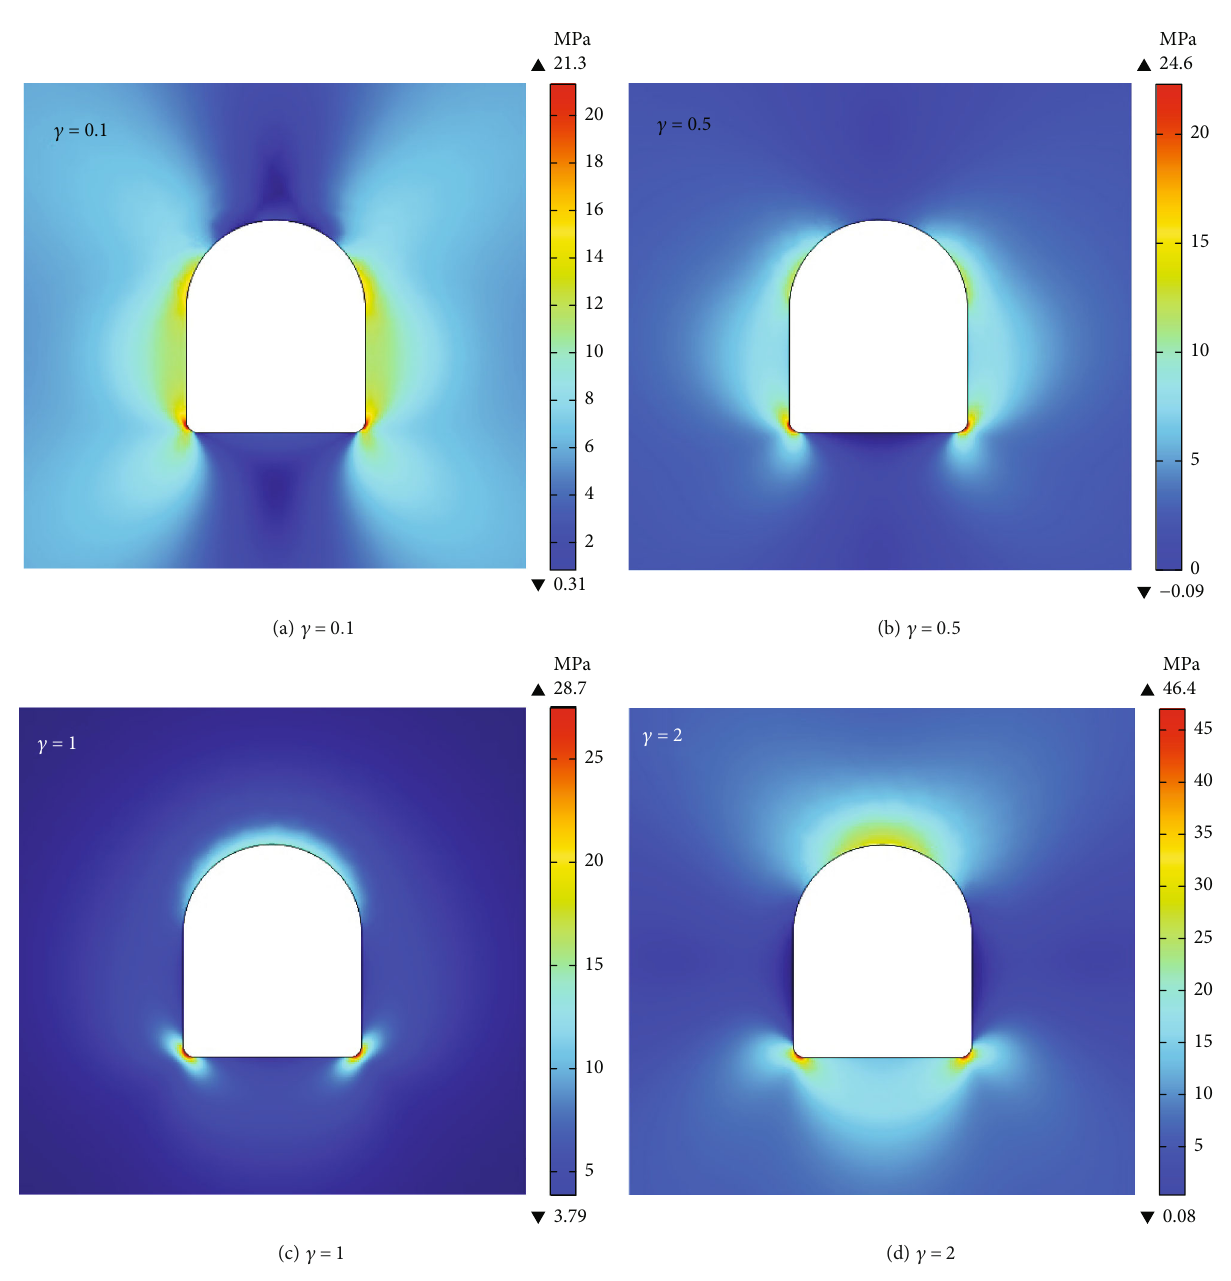
Figure 10: The Mises stress distribution of rock mass of karst